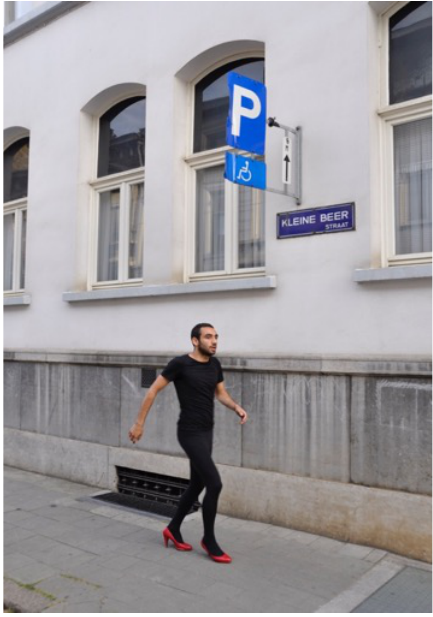
Mehdi-Georges Lahlou, Walking 30km with red high heel shoes between 2 art spaces (detail), 2009. From Galerie Transit, Mechelen to Lokaal 01, Antwerp, Belgium. 9-hour performance. Image courtesy of the artist and Galerie Transit,